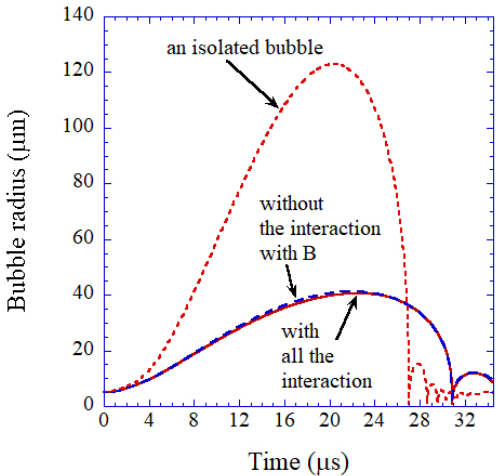
Figure 19. Calculated radius of a bubble in the cloud A in Figure 18 as a function of time for one acoustic cycle at 29 kHz and 2.36 bar in frequency and pressure amplitude of ultrasound, respectively [19]. The ambient bubble radius is 5 µ m. The dotted line is the calculated result neglecting all the interactions with other bubbles (an isolated bubble). The dashed line is the calculated result neglecting only the interaction with the bubbles in the cloud B. The solid line is the calculated result taking into account all the interactions with surrounding bubbles. Copyright 2008, with the permission from American Physical Society.